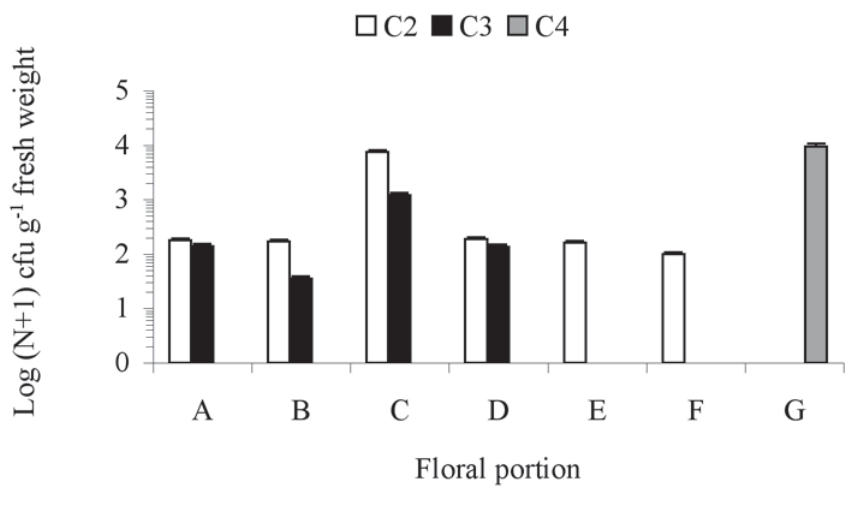
Fig. 4. Different epiphytic bacteria on gerbera cv. Provence portions after 6 d (see legend on Fig. 1): C2, Acineto- bacter sp.; C3, Pantoea agglomerans ; C4, Bacillus pumilus . Data represent the means (±SD) of 10 flowers.